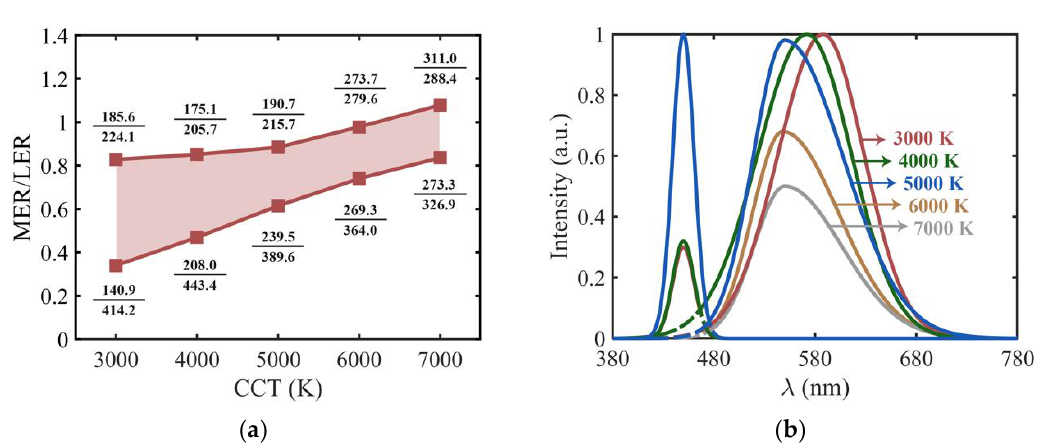
Figure 6. ( a ) Maximum and minimum MER/LER as functions of CCT; ( b ) spectra with minimum MER/LER from 3000 to 7000 K, of which LER is restrained at over 330 lm/W and Ra at over 60. Table 2. Spectral characteristics with minimum MER/LER from 3000 to 7000 K.